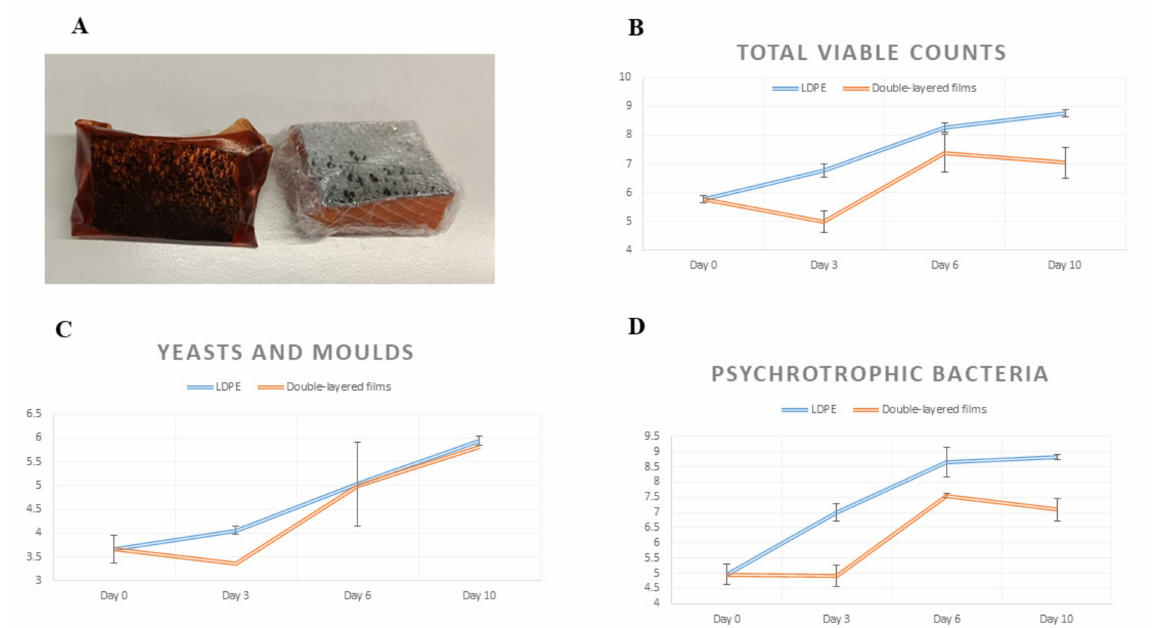
Figure 3. ( A ) The method of packing salmon in 2 types of films. ( B ) Total aerobic bacteria in Salmo salar fillets; ( C ) yeasts and molds in Salmo salar fillets; ( D ) psychrotrophic bacteria in Salmo salar fillets. Films: samples stored in innovative films; LDPE: control group samples stored in synthetic